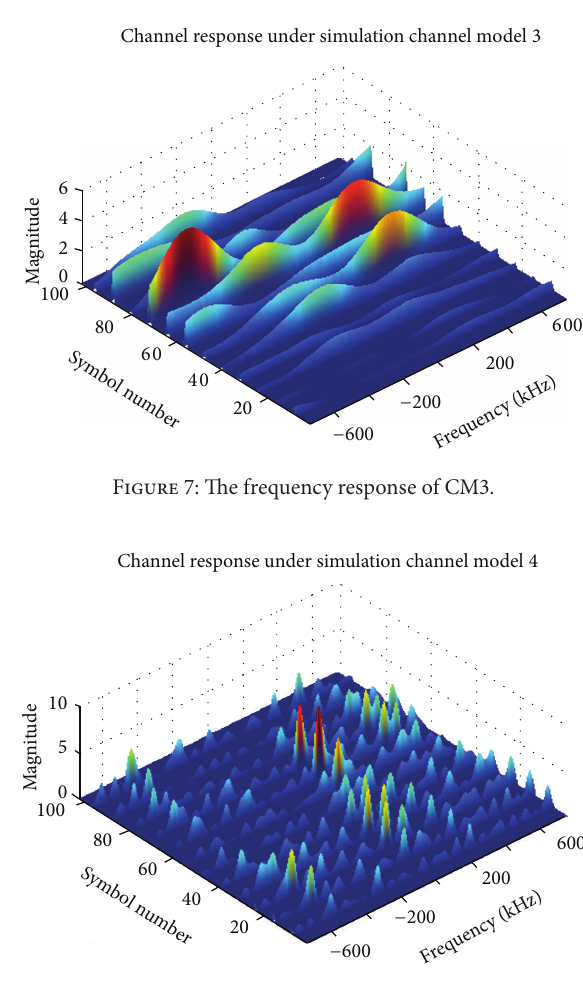
Figure 8: The frequency response of CM4.